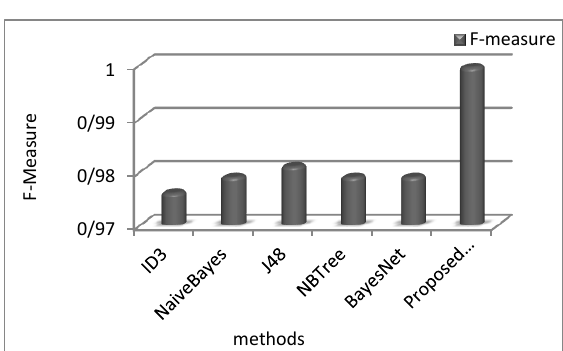
Figure 6. Comparison between proposed method (with 27 tees in decision forest) and basic classification algorithms based on precision.